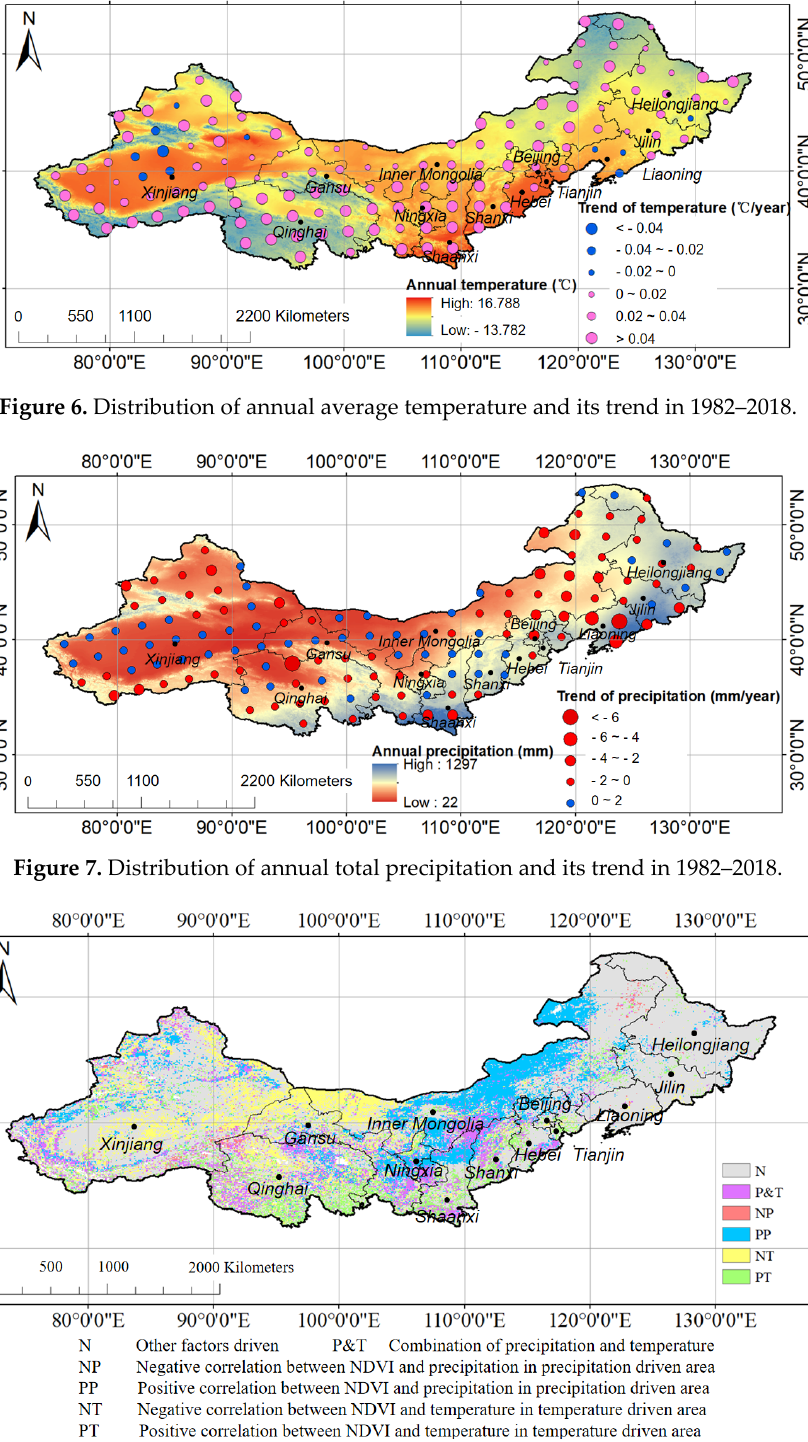
Figure 8. Distribution of the four NDVI driver types and the relationship between NDVI and precipitation/temperature for northern